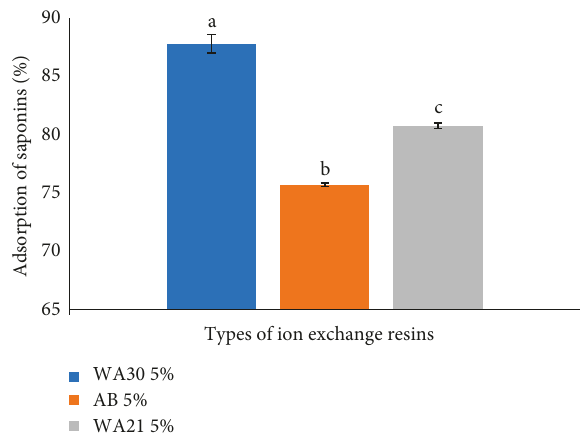
Figure 4: Percentage of saponins adsorbed (%) by three different weakly basic ion exchange resins at 5% (w/v) adsorbent dose. a–c: different alphabets indicate a significant difference ( p